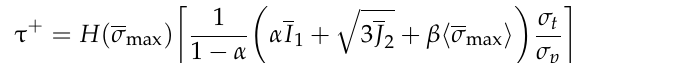
( b ) Figure 3 . Wall geometry: ( a ) element dimensions (m), numbering of masonry piers, and ( b ) layout of the numerical model. The homogenized compressive strength of masonry is assumed to be equal to 3.2 MPa. For the micro-model, the mechanical parameters are divided between those inherent P1 P2 P3